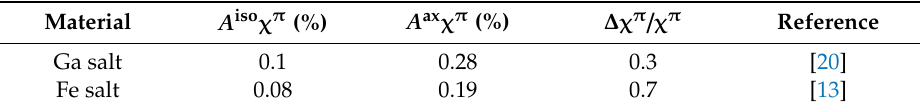
Table 1. NMR parameters of the Ga and the Fe salts obtained by Refs